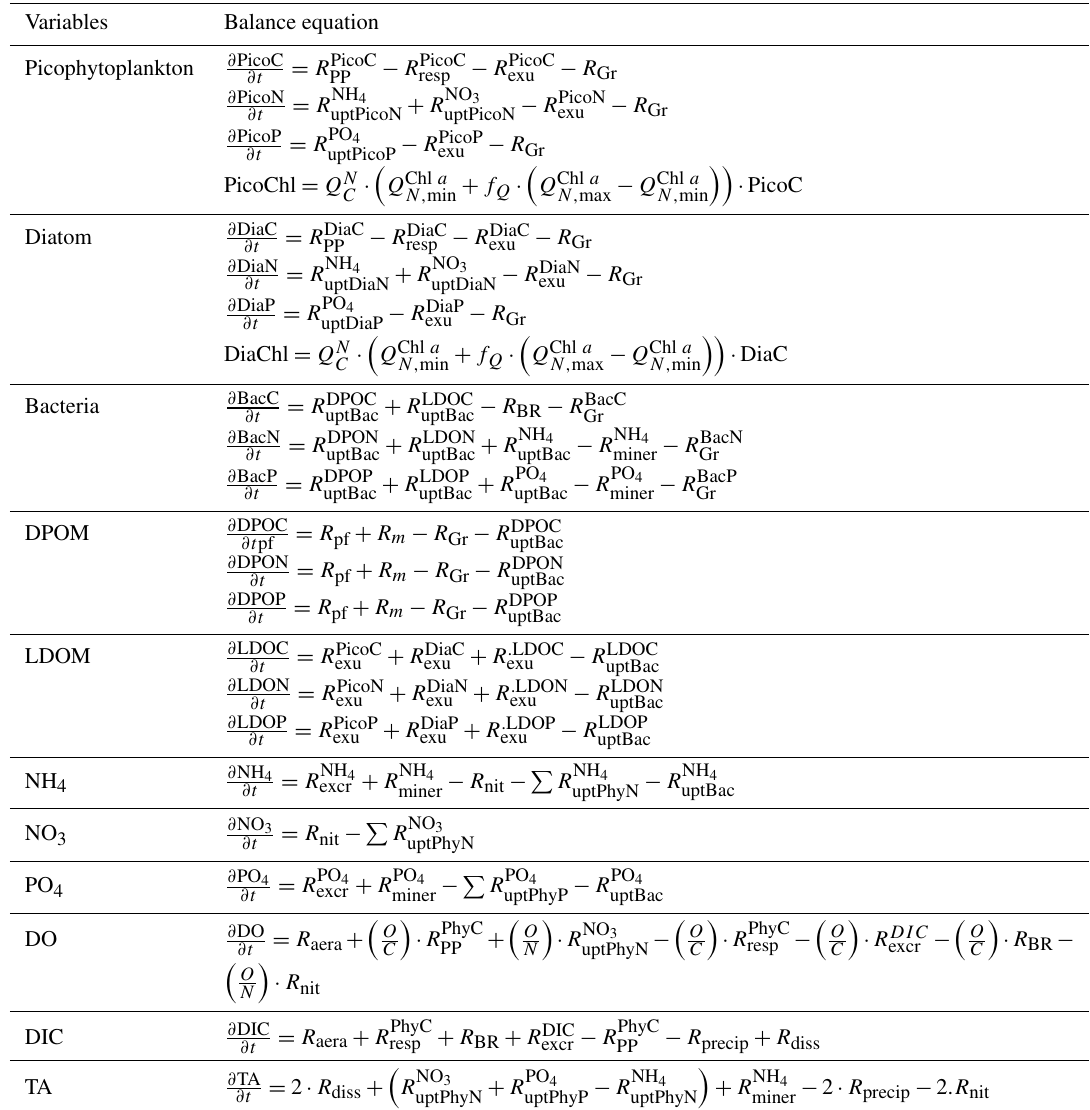
Table B2. Balance equations of the Eco3M-CarbOx model. Variables Balance equation